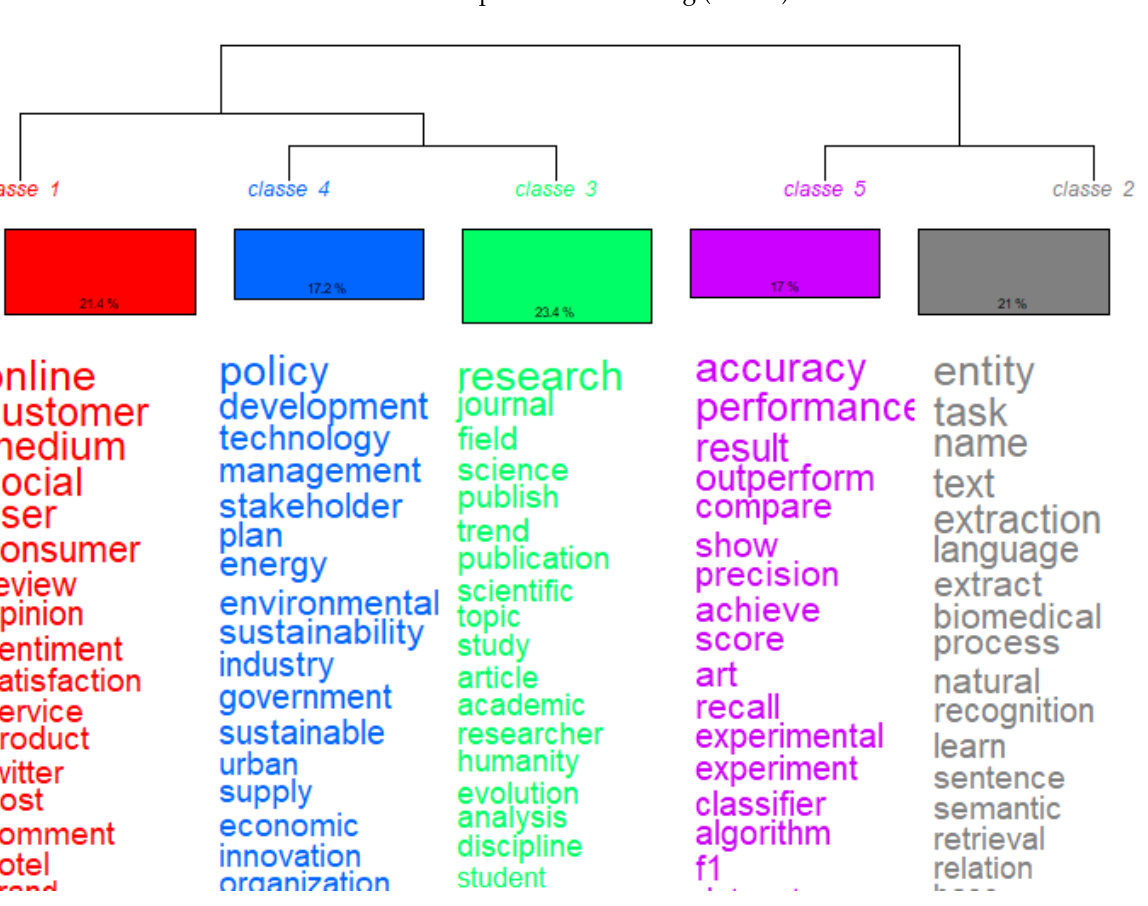
Figure 16. SRL of text mining using Reinert’s method.